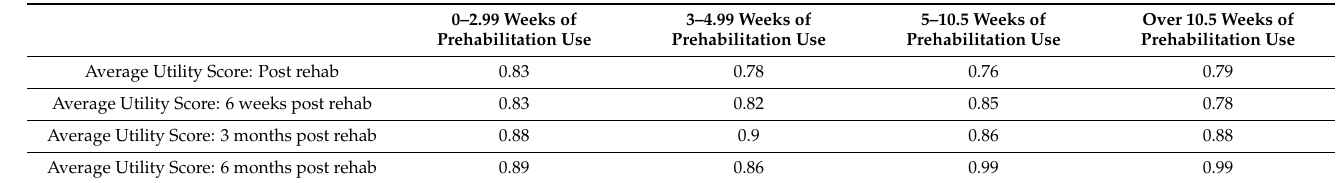
Table 4. Average total QoL in each prehab duration of use band (in weeks).